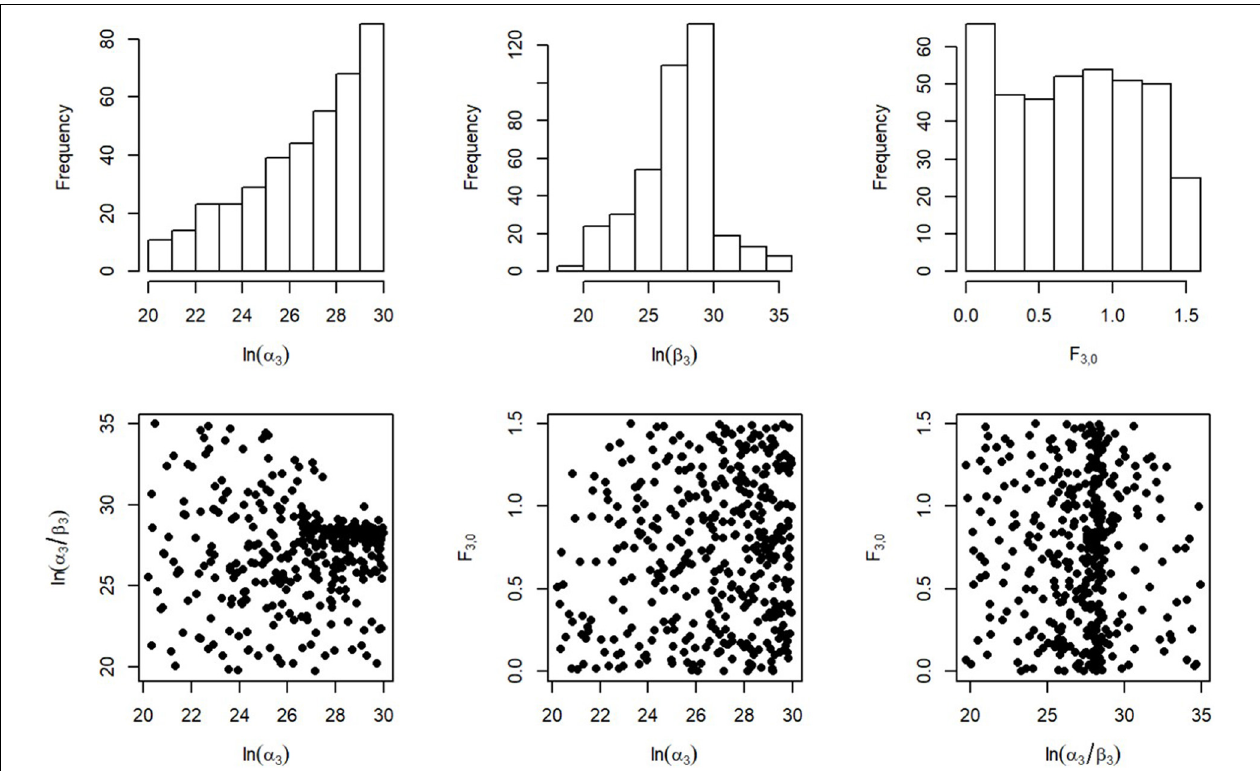
FIGURE 1 | Distribution of possible starting points for the stock-recruit parameters α and β , and the spin-up fishing rate F0 for herring. The spin-up fishing rate is a constant rate of fishing applied to the stock throughout the spin up period of 100 years before the commencement of the simulation proper.